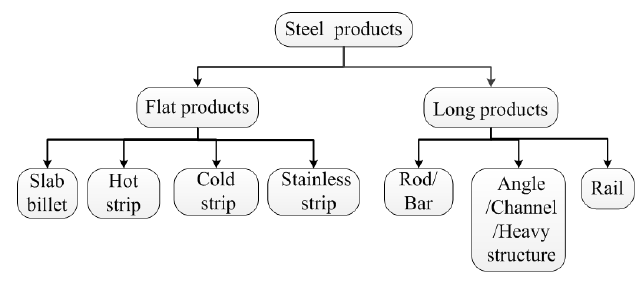
Figure 2. Types of steel products (reproduced from Neogi [15]).